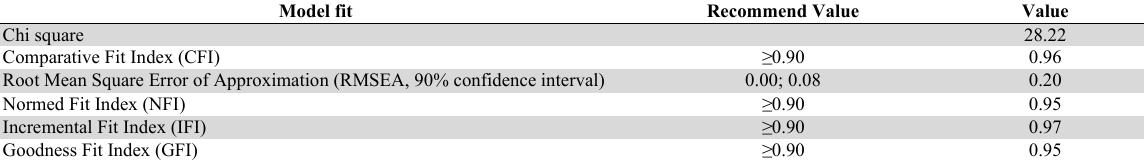
Summary of model